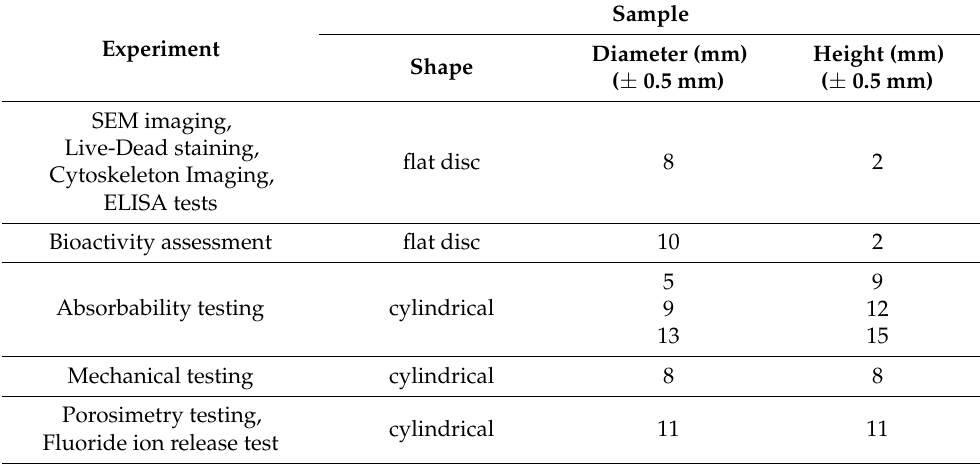
Table 3. Shape and size of composites samples used in the